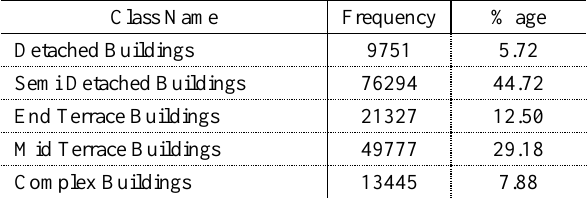
Table 6. The summary of building classification based on selected decision tree model.